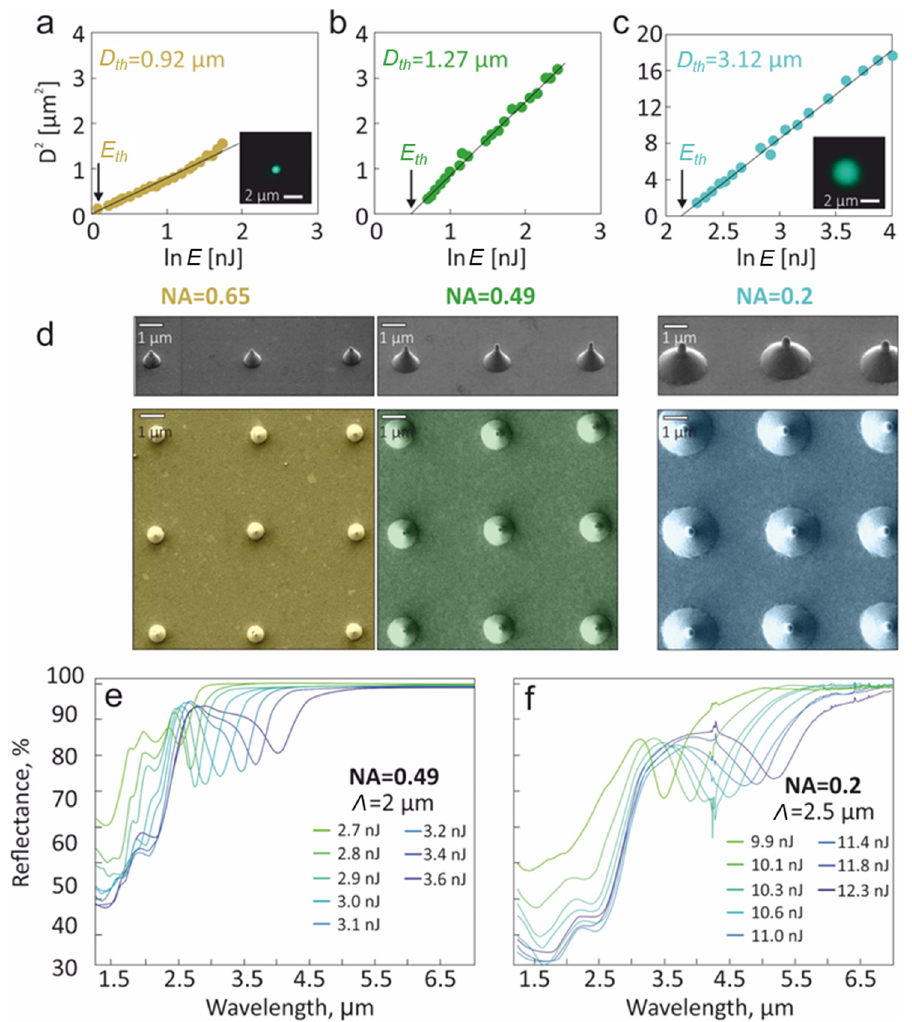
Figure 2. ( a – c ) Squared lateral size of the surface modification (nanobump or nanojet) D 2 as a function of the natural logarithm of the applied pulse energy ln E (in nJ) measured for three calibrated positions of the iris aperture that tailors the optical diameter D opt of the laser focal spot. Corresponding linear fits of the obtained data give the characteristic energy deposition diameters D th of 0.92 ( a ), 1.27 ( b ) and 3.12 µm ( c ). The intersection of the linear fit with the x-axis indicates the threshold applied pulse energy E th = 1 ( a ), 1.7 ( b ) and 8.4 nJ ( c ). Insets in ( a ) and ( c ) provide focal-plane optical images of the resulting laser beam used for nanostructure fabrication. ( d ) Series of side-view (view angle of 45°) and top-view SEM images showing a scalable increase in the geometric dimensions of the laser-fabricated nanostructures (a nanobump with a small nanojet atop) upon the decrease in the effective NA of the microscope objective from 0.65 to 0.2 using an adjustable iris aperture. All nanostructures were produced at a fixed fluence of 0.21 ± 0.02 J/cm 2 . ( e , f ) FTIR reflectance spectra of the nanostructure arrays (200 × 200 nanostructures) produced using laser beam focusing at effective NA of 0.49 ( e ) and 0.2 ( f ). The array period Λ was 2 ( e ) and 2.5 µm ( f ).